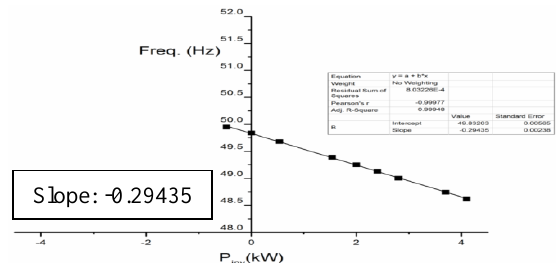
Figure 9. The f-P droop curve of one battery inverter (phase A).